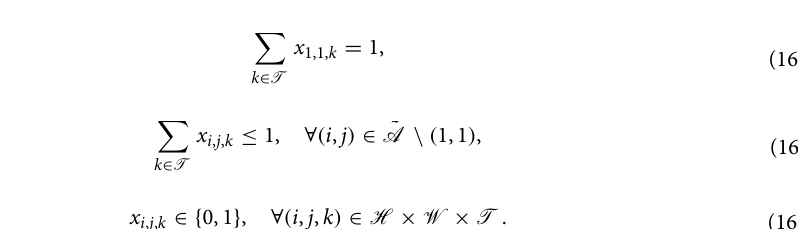
Figure 6. Six possible placements of tiles p , q , r , and s . While the combinations ( a ) and ( c )–( f ) can appear in rectangular tilings, the combination ( b )